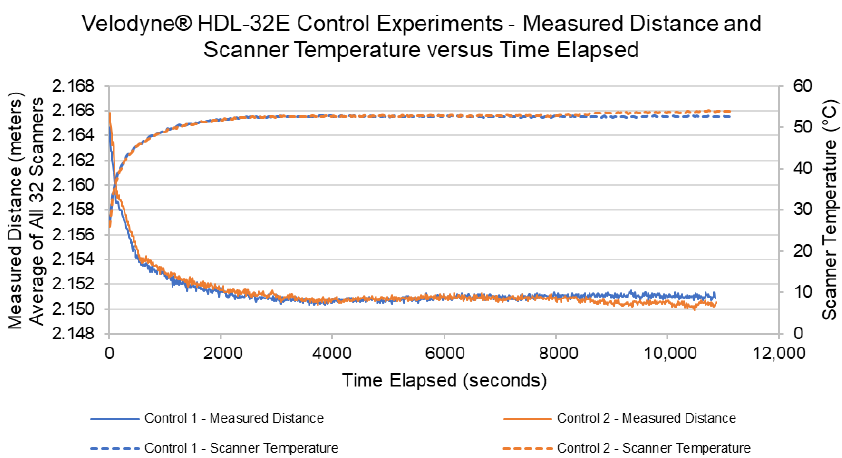
Figure 16. Velodyne ® HDL–32E indoor experiment overall average measured distances (m) plotted over time elapsed with scanner internal temperature (°C).